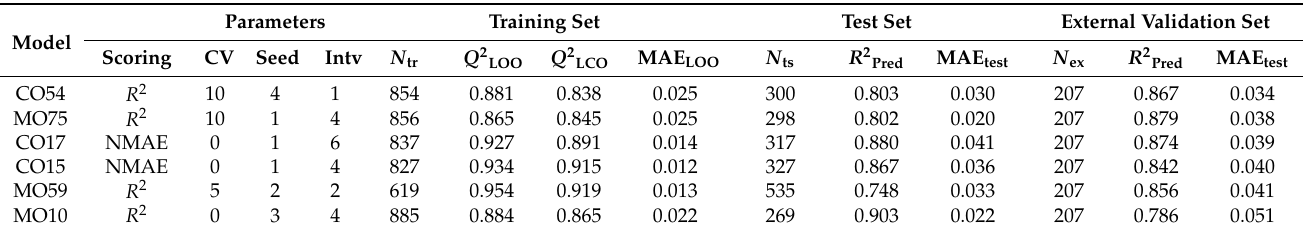
Table 4. Summary of the performance of the best three MO-based and best three CO-based QSPR models (sorted by the MAE test values) obtained for the external validation set.